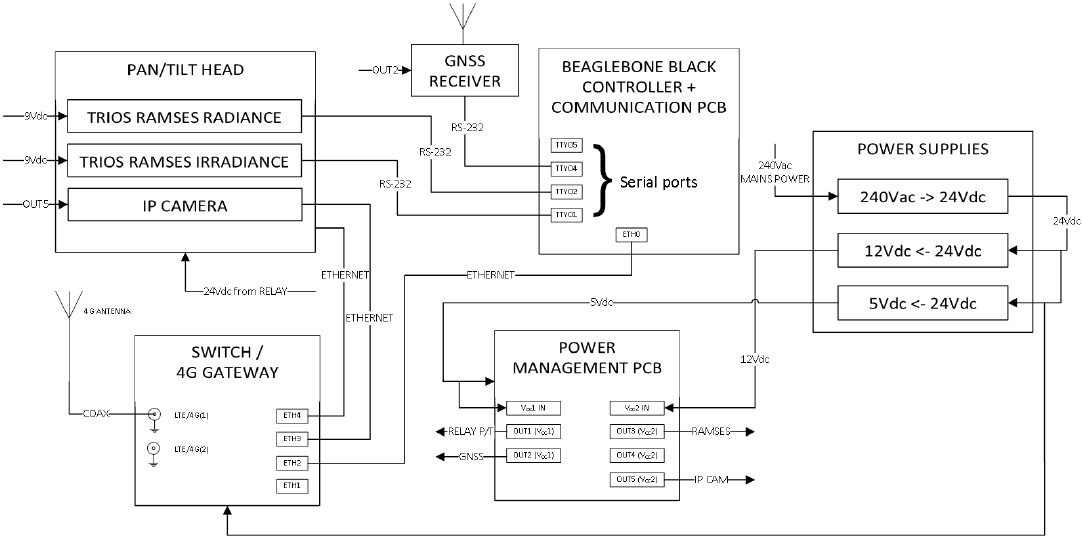
Figure 1. Pan-and-tilt hyperspectral radiometer system (PANTHYR) system diagram.